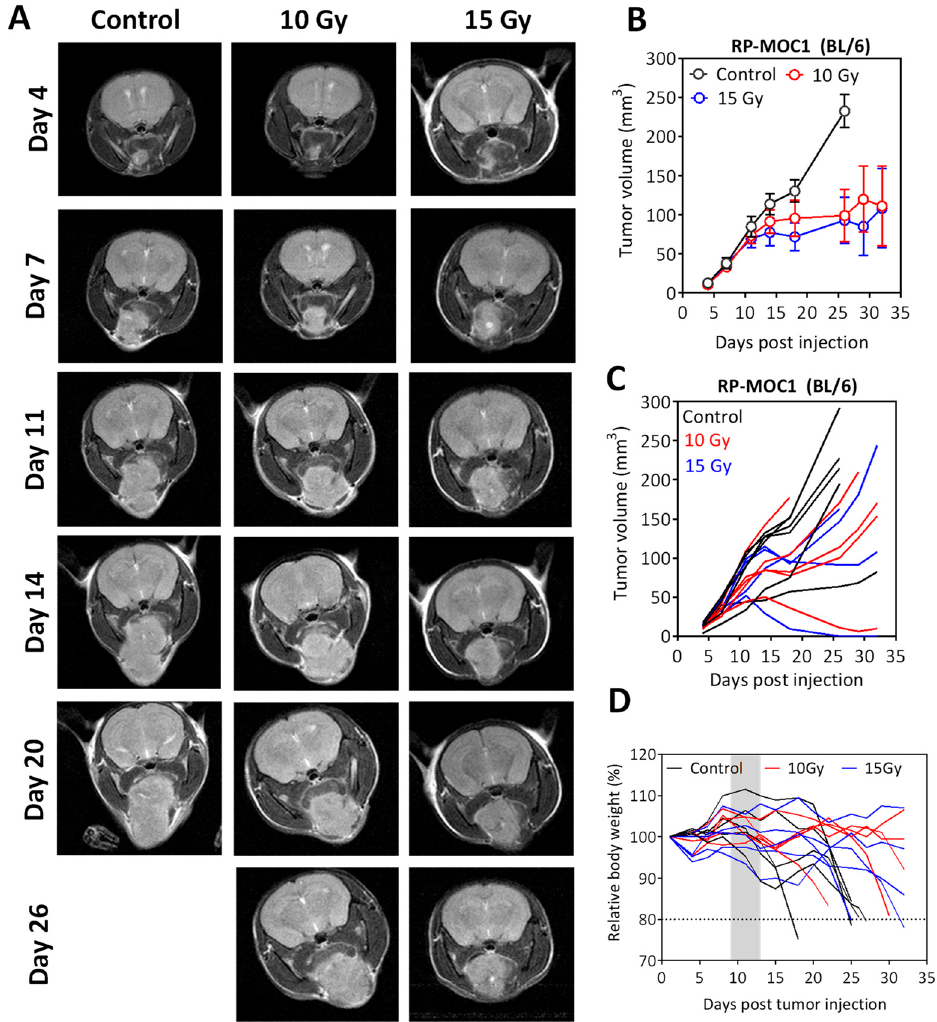
Figure 4. Radiation response of orthotopic RP-MOC1 tumors in immunocompetent mice. ( A ) Panel of images represents axial T2-weighted images of albino C57Bl/6 mice bearing orthotopic RP-MOC1 tumors during a 30-day monitoring period. Longitudinal MRI was performed once every 3–4 days during this period to assess tumor growth and response to radiation. Individual ( B ) and grouped ( C ) tumor growth curves based on MR-based tumor volume measurements obtained for animals in the control and radiation groups are shown. ( D ) Body weight measurements of animals in all three groups did not reveal any evidence of radiation toxicity. A gradual reduction in body weight associated with tumor growth was seen during the observation period.